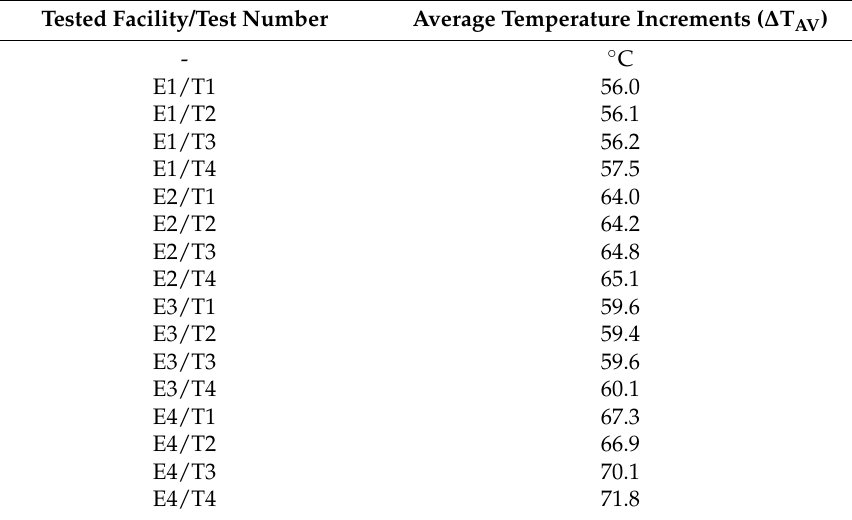
Table 7. Determined average temperature increments of tested LED lighting sources.